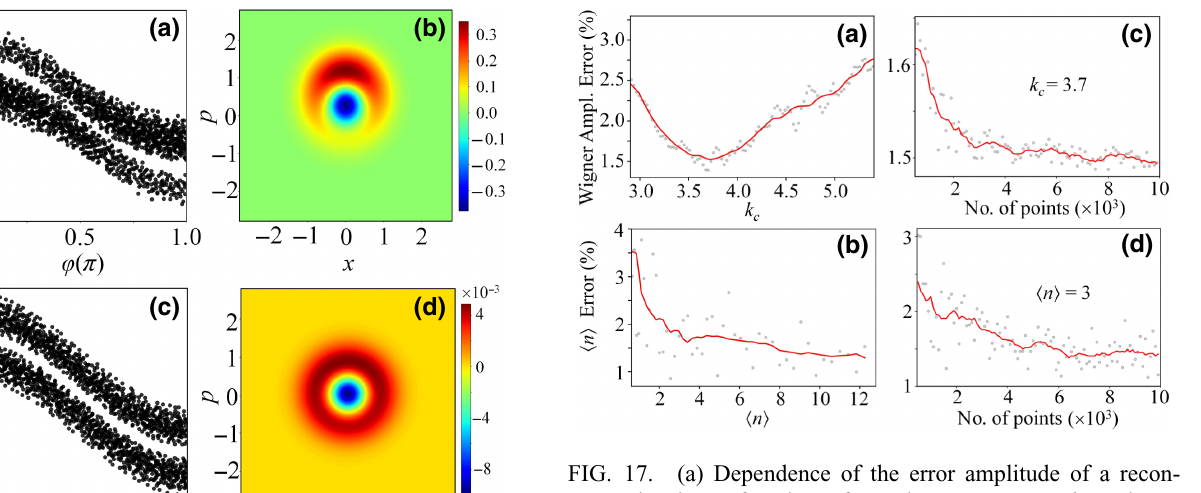
FIG. 17. (a) Dependence of the error amplitude of a recon- structed Winger function of a coherent state on k c , using a homodyne trace with about 10 4 points for 0 ≤ φ ≤ π . (b) Depen- dence of the accuracy of measuring the mean photon number on the mean photon number of the light state. (c) Dependence of the Wigner function amplitude error on the number of points of the measured homodyne detection signal x φ for k c ≈ 3.7. (d) Depen- dence of the accuracy of measuring the mean photon number of the light state on the number of points of the measured homodyne detection signal x φ for (cid:10) n (cid:2) = 3. In all graphs, the red solid line is a 15-point running average of the data (gray points). Panels (a) and (b) are reproduced from Ref.